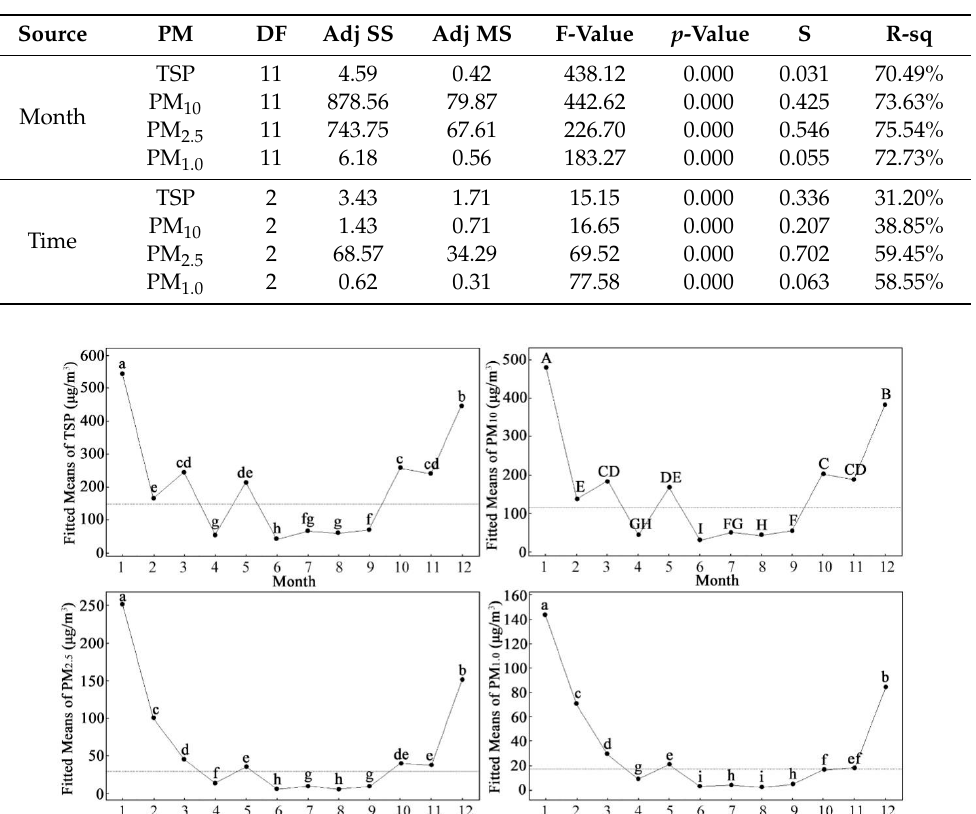
Figure 4. Differences of atmospheric suspended particulate matter concentration in different months. The lower-case letters in the figure represent the grouping information obtained by multiple comparisons of means using the Tukey method. Forests 2020 , 11 , x FOR PEER REVIEW